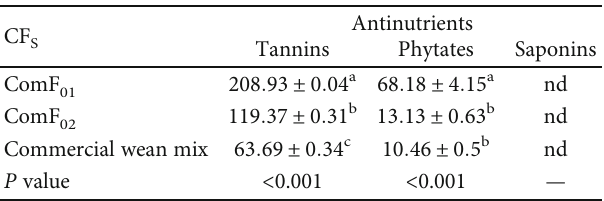
The results are presented as SD of the means. ComF 01 : complementary foods (white maize+red te ff +soybean); ComF maize+red te ff +insect bee larvae); nd: not